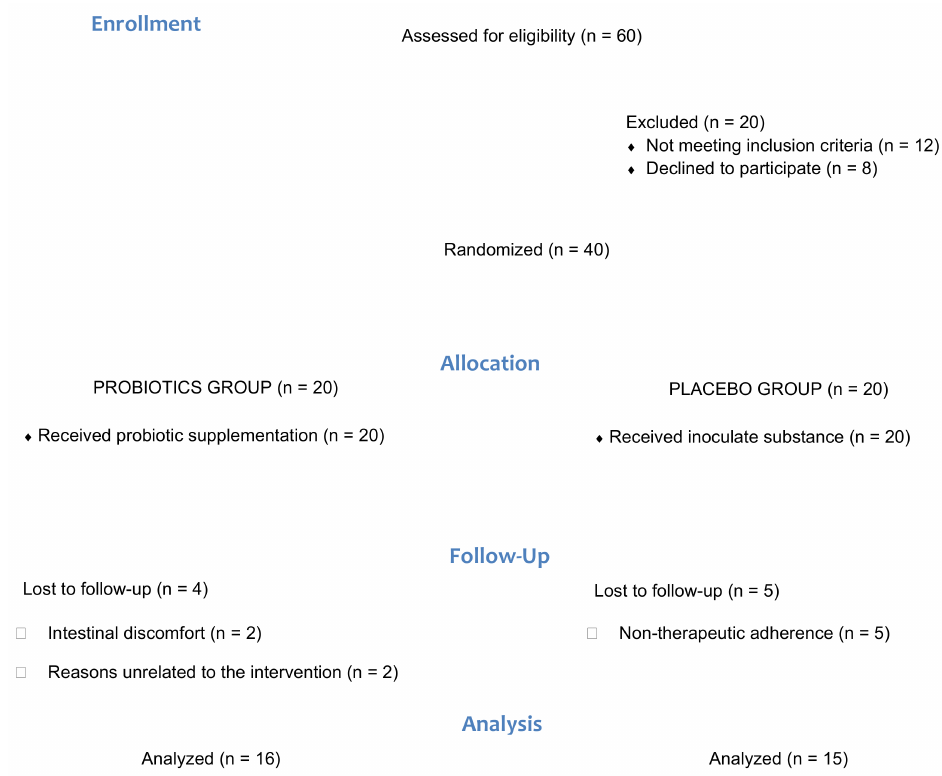
Figure 1. Flow diagram of the progress through the phases of the pilot parallel randomized trial of two groups.